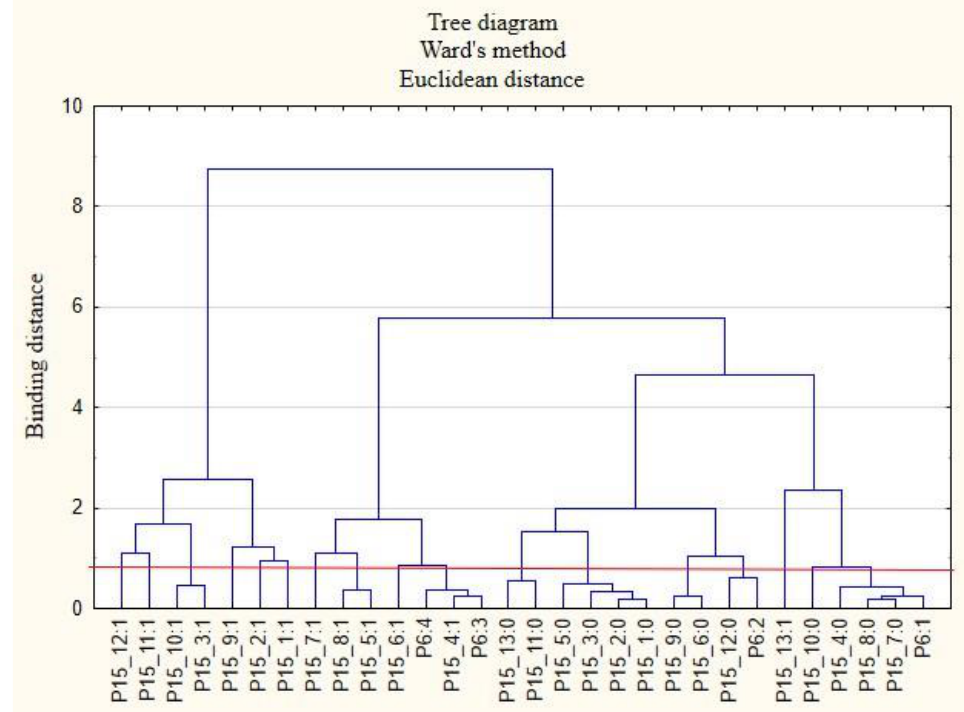
Figure 5. Diagram of hierarchical classification of variable categories: support received during the COVID-19 pandemic from the employer in the area of healthcare and the effective use of the benefits offered (P15) as well as the positions in which the respondents work (P6).